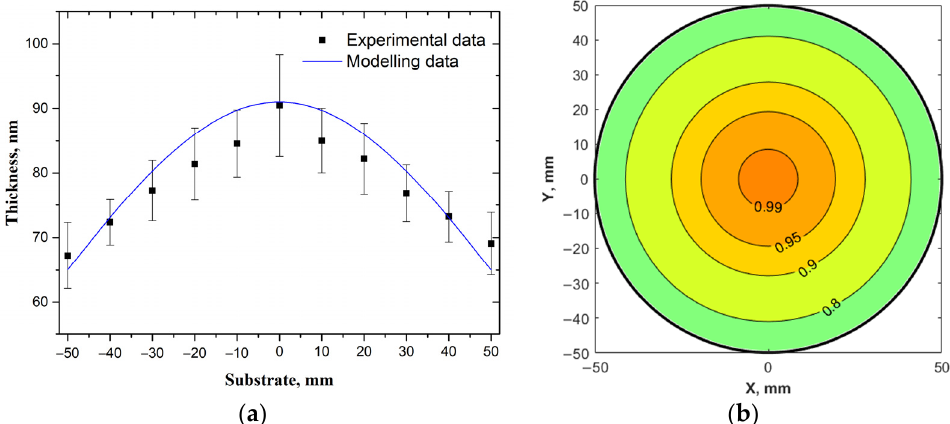
Figure 5. Comparison of the experimental results (points) and simulation (line) ( a ), as well as the distribution of the relative thickness of the LiNbO 3 film on a substrate with a diameter of 100 mm ( b ).